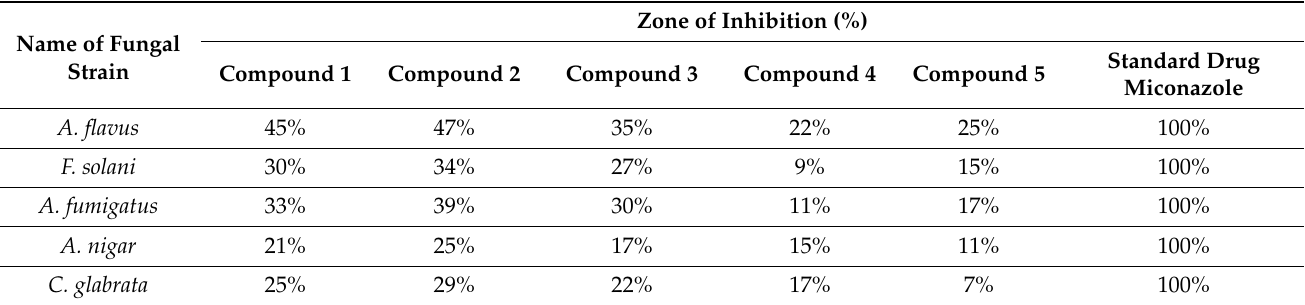
Table 5. Antifungal activities of compounds 1 – 5 (30 µ g/mL) against different fungal strains. Name of